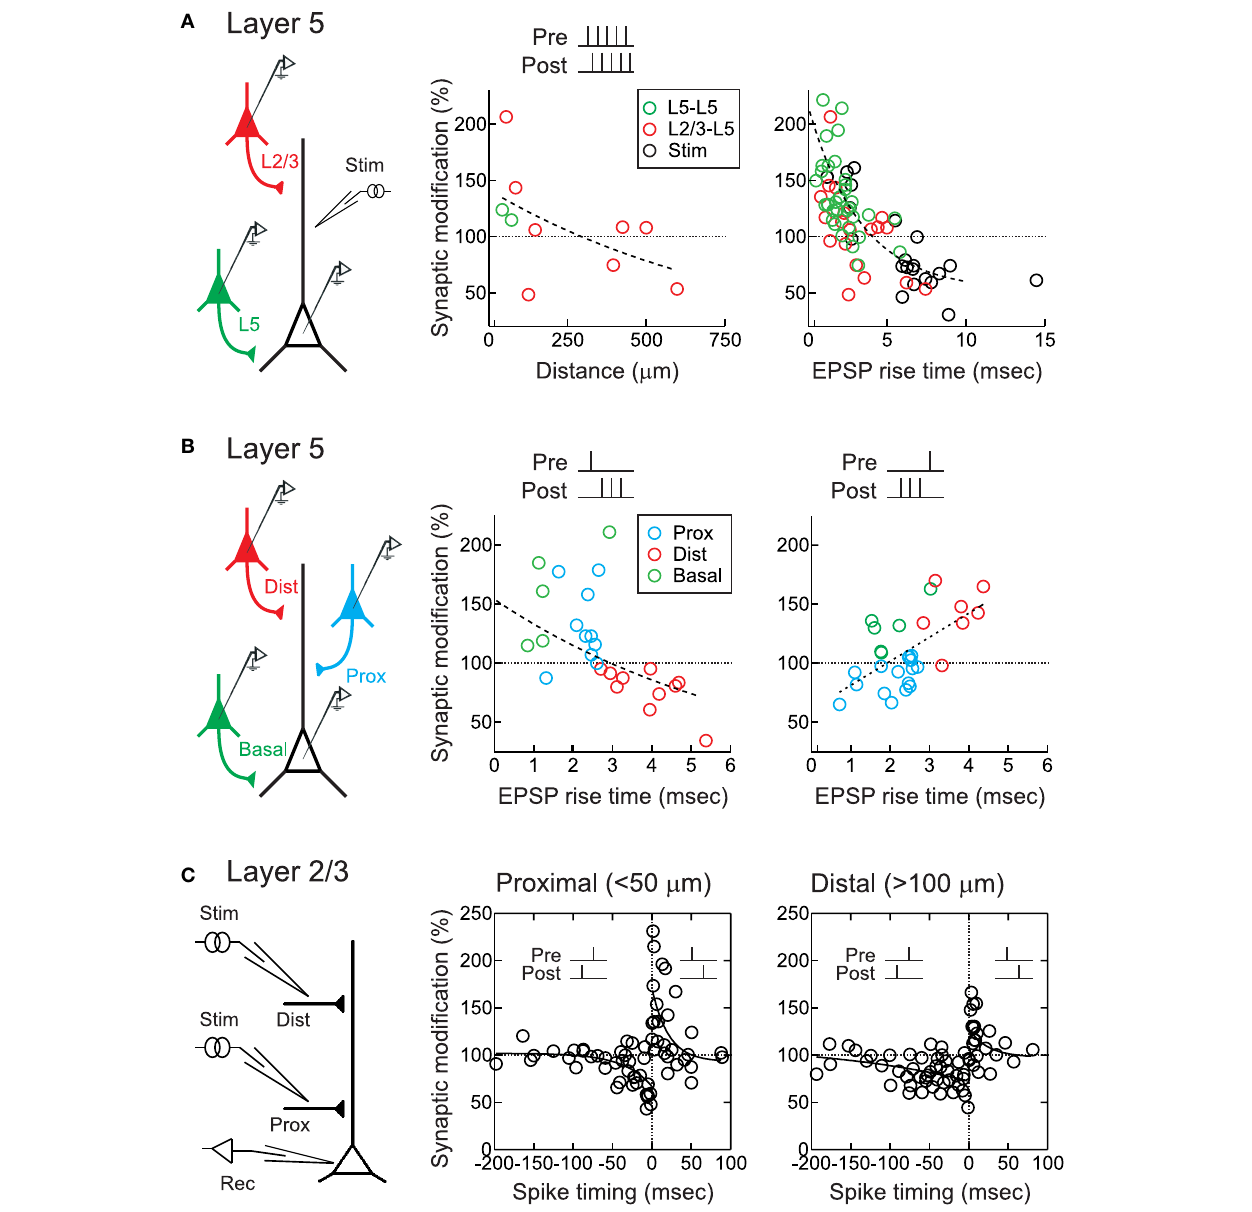
Figure 1 | STDP timing rules depend on dendritic synapse location. (A) STDP of layer 2/3 (red) and layer 5 (green) EPSPs in layer 5 pyramidal neurons. EPSPs were evoked during paired recordings or by extracellular stimulation (“stim”, black). STDP was induced by repetitively pairing of five pre- and five postsynaptic action potentials/stimulations at + 10 ms. Center, sign of synaptic modification was negatively correlated with distance of putative synaptic contact. Right, sign of synaptic modification was negatively correlated with EPSP rise time. From Sjöström and Häusser (2006). (B) STDP of proximal (blue) and distal (red) apical layer 2/3 inputs, and basal (green) layer 5 inputs, to layer 5 pyramidal neurons. Somatic EPSP rise time was used as a proxy for synaptic location, with fast EPSPs ( < 2.7 ms) indicating proximal EPSPs and